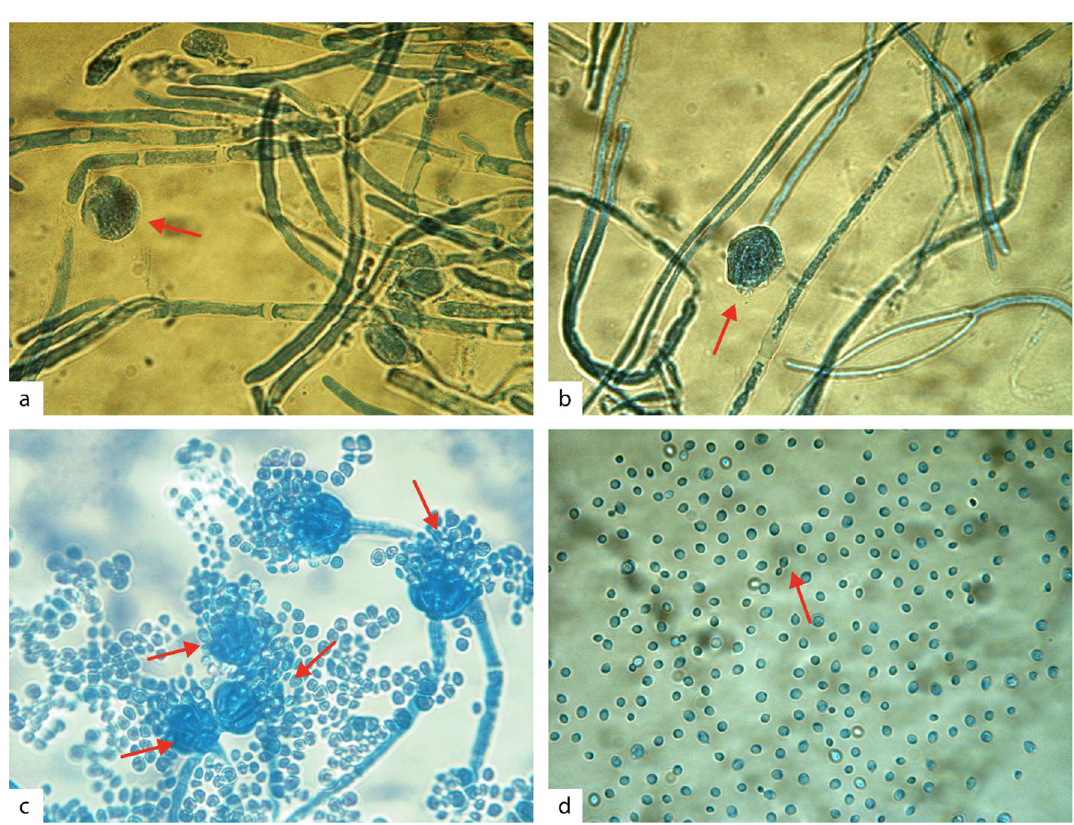
Figure 3. Microscopic structures of Antarctic fungi isolates observed under a compound microscope with 1000 × magnification. ( a ) Cryptococcus gilvescens , showing budding division of cells (arrow); ( b ) Penicillium sp., showing their septate stipes and conidia at the top of phialides (arrows); ( c ) Thelebolus sp., showing hyaline septate hyphae and ascospores (arrow); and ( d ) Antarctomyces sp., showing septate hyphae and ascospores (arrow). Microscopic structures were observed at 15 days ( a ), and 30 days ( b – d ). Scale bar 10